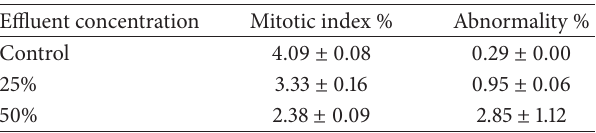
Table 2: Effect of tannery on mitotic index and abnormality % in V. mungo under different